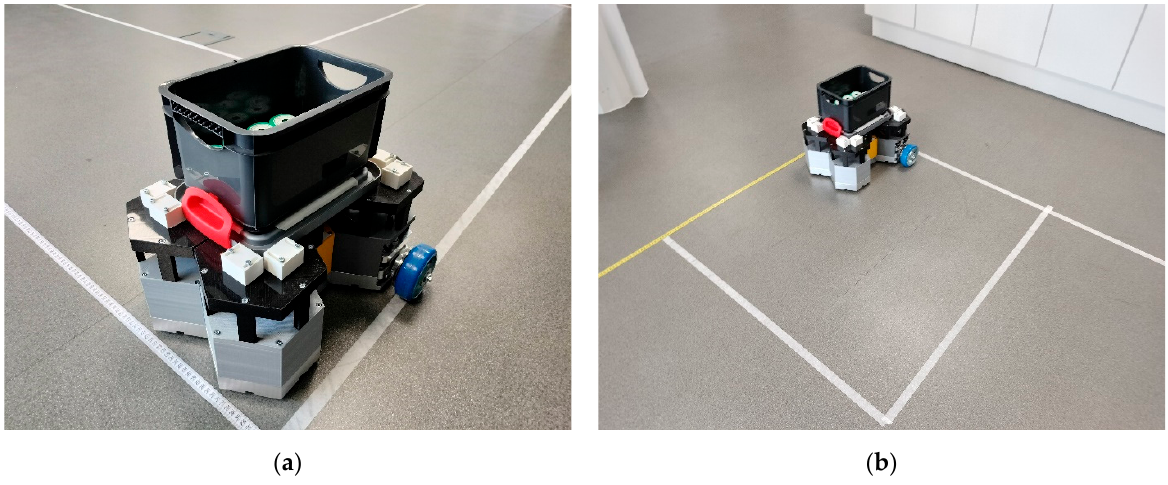
Figure 37. Physical path and real mobile robot. ( a ) Close view. ( b ) Mobile robot on the path.